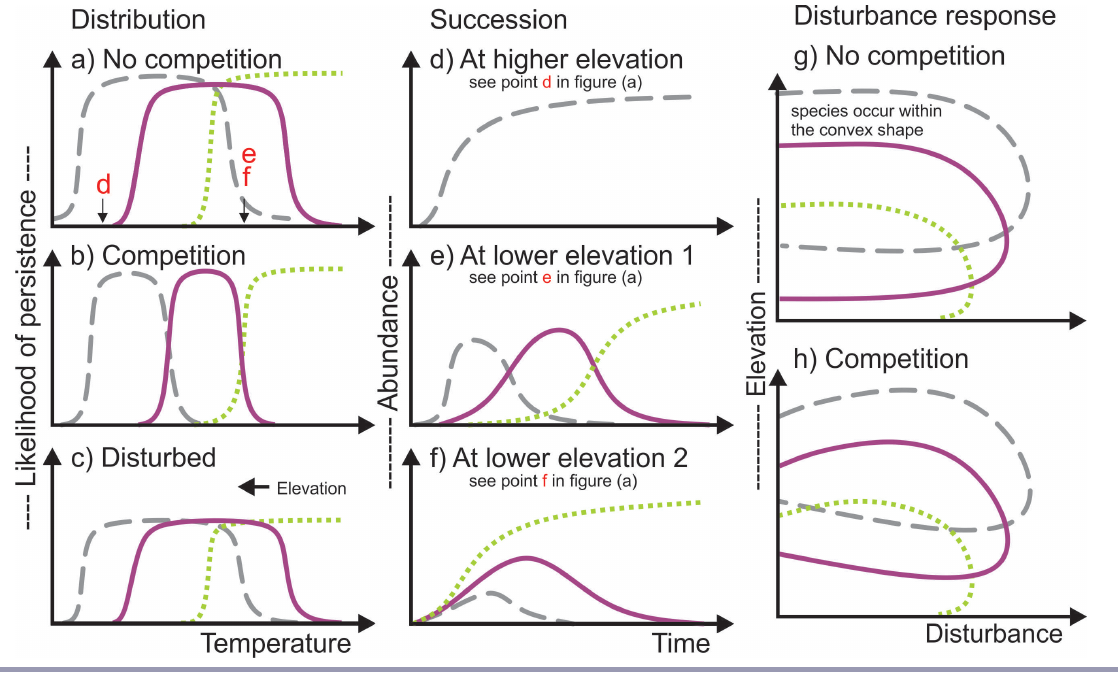
Fig. 2 . Schematic distribution, succession, and disturbance relationships of three idealized species on a temperature (reverse elevation) gradient. Their fundamental niches (a) are broader than their realized niches (b), but with disturbance, species cover a broader range of conditions and competition is reduced (c), peaks are lower because limited space and more species implies reduced mean likelihood of any one species occurring at any one location. At high elevation, only one of the three species can tolerate the low temperatures (d); at lower elevation all three species can become established and competition subsequently leads to exclusion and thus succession (e and f). If there is no competition, disturbance has little impact on species distributions until high frequency and/or intensities interfere with species being able to complete their life cycle (g); species occur only within the concave lines of their color. When species compete as a competitive hierarchy, moderate disturbance leads to a less constrained distribution and to improved persistence at both higher and lower elevations than would otherwise occur (h). Figures (e) and (f) highlight that there may be a trade-off in which high elevation species are better colonists (a pattern observed in many tropical mountains (e), or not (f), but in both cases there is a period in which high elevation species can establish and pre-empt space at low elevations). This assumes dispersal but note that under climate change, reaching warmer sites is a matter of persistence over time. The arrows in (a) labeled with a red (d), (e), and (f) indicates the approximate location on the elevation of the succession shown in figures (d), (e), and (f), respectively. It is important to note the limitation of presenting disturbance on a single axis and uniformly for an entire gradient. In reality, we can modify many aspects of disturbance and decide whether such changes are uniform or targeted more